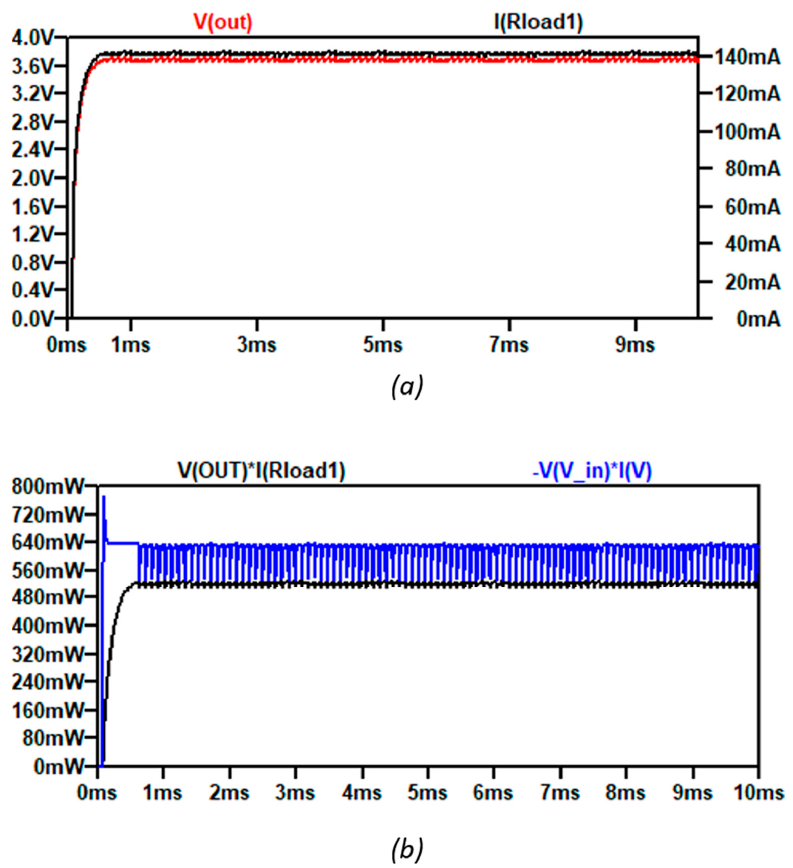
Figure 18. Simulation of TEH prototype for ∆ T = 34.5 K. ( a ) Output current (blue) and output voltage (black) ( b ) Input power (black) and output power (red).